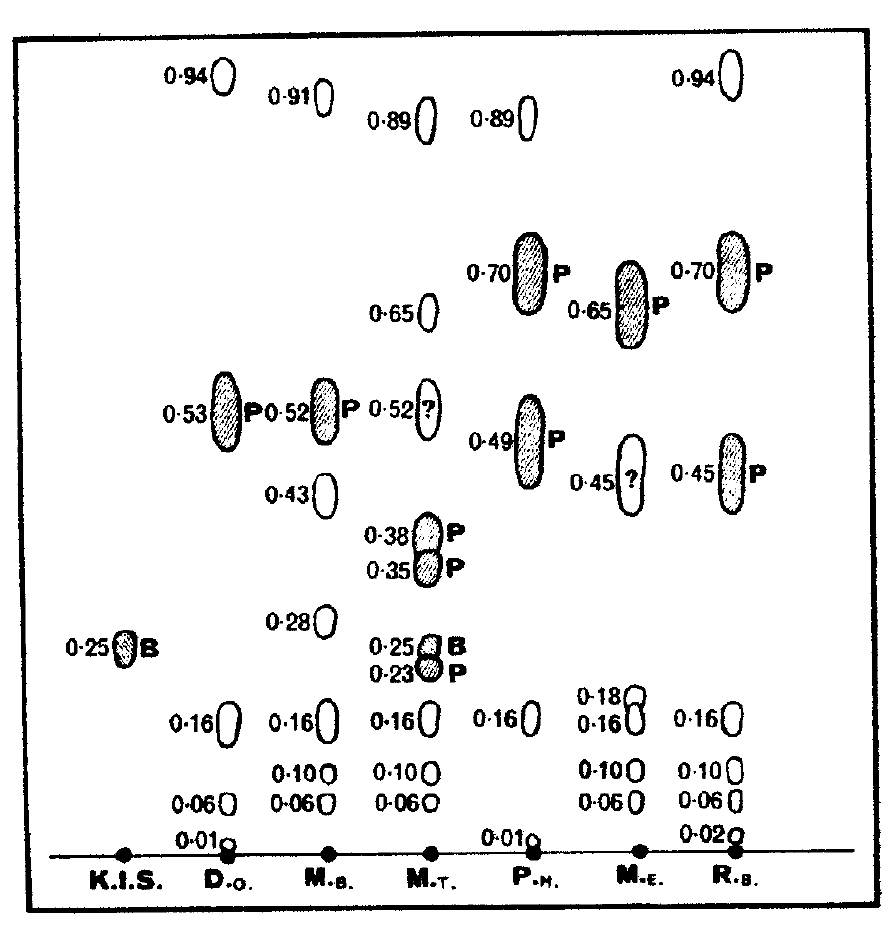
Figure 10. Paper chromatography of ethanol extracts of purple molluscs, Dicathais orbita , Murex brandaris , Murex trunculus , Purpura haemastoma , Murex erinaceus and Rapana bezoar compared with potassium indoxyl sulfate (K.I.S)